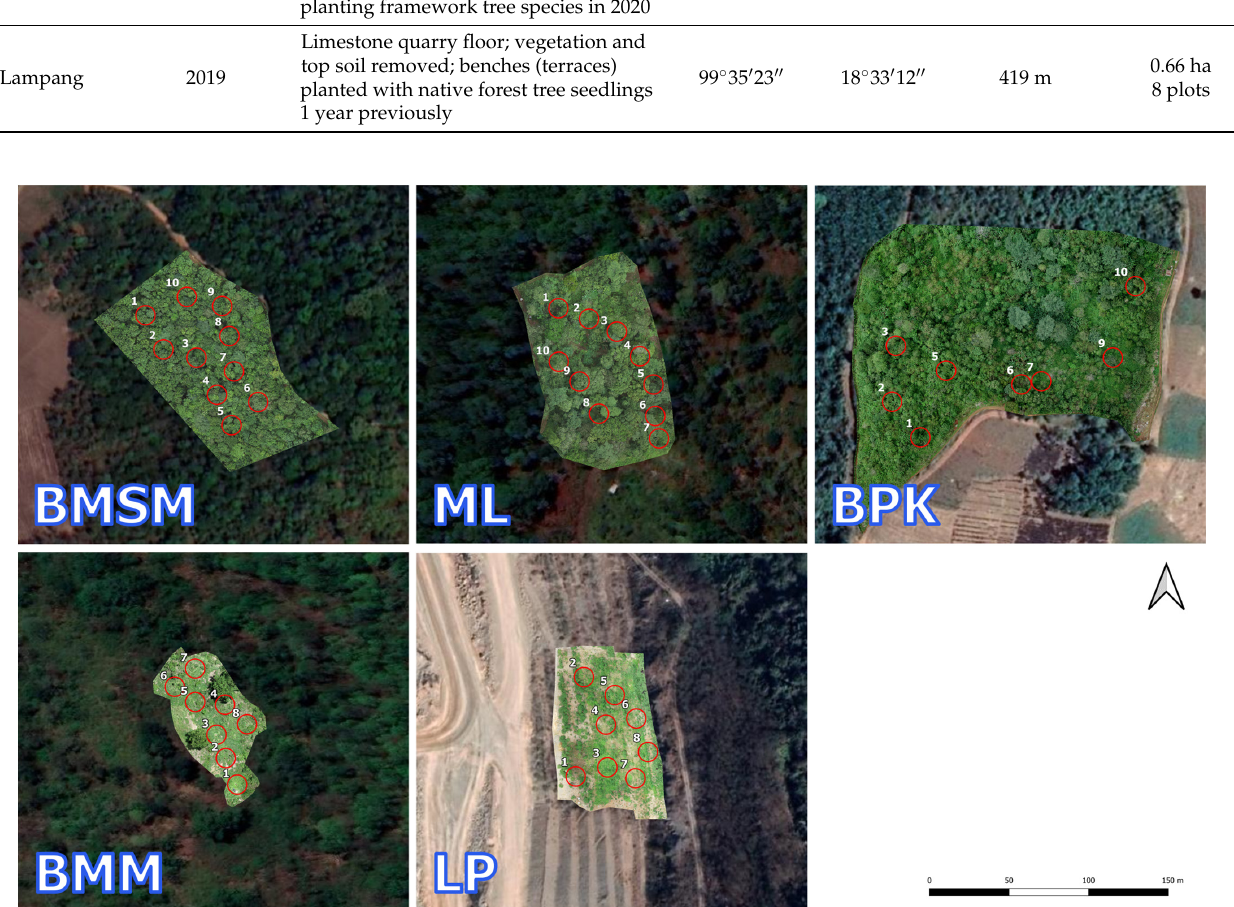
Figure 2. Orthophotos showing the size, shape, and boundaries of the five sites with a unified scale: BMSM = Ban Mae Sa Mai, ML = Mon Long, BPK = Ban Pong Krai, BMM = Ban Meh Meh and LP = Lampang. Red circles are sample plots. White figures are plot id. numbers.